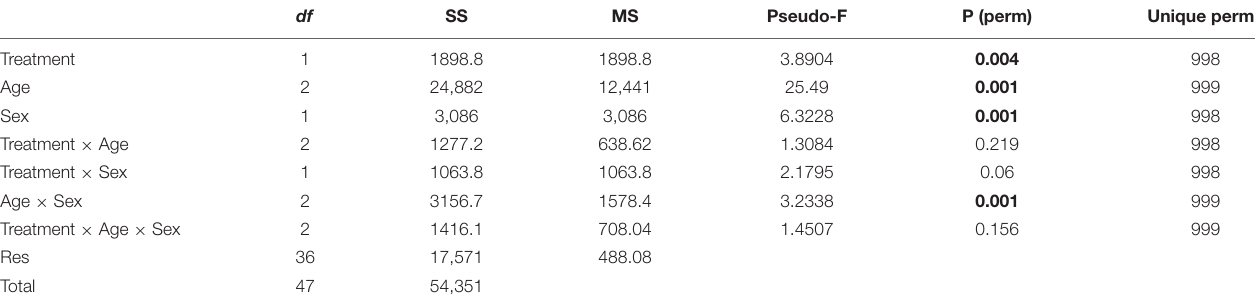
TABLE 2 | PERMANOVA table of results for all three factors and their combinations for genera level abundance. df SS MS Pseudo-F P (perm) Unique perms Treatment 1